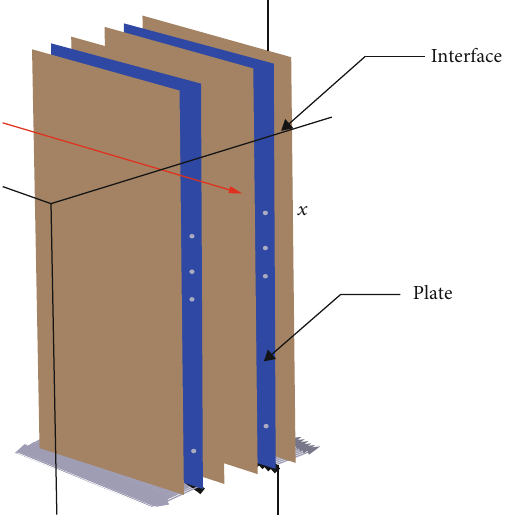
Figure 7: Interfaces in the PLAXIS-3D model.